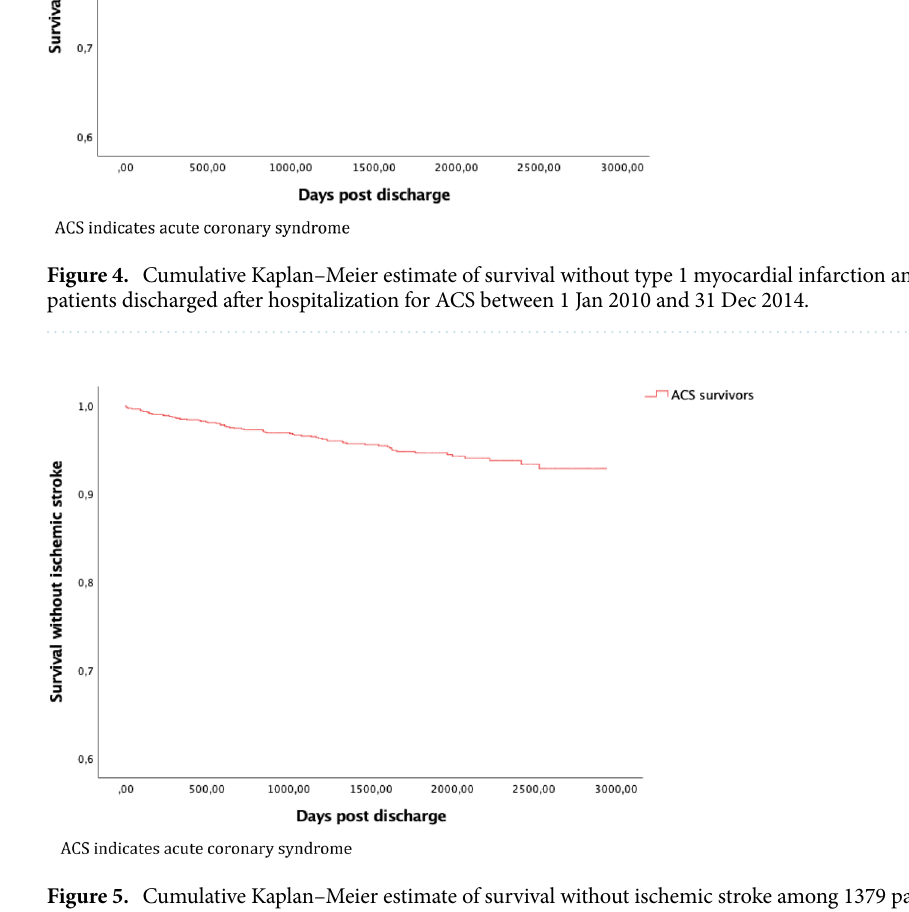
Figure 5. Cumulative Kaplan–Meier estimate of survival without ischemic stroke among 1379 patients discharged after hospitalization for ACS between 1 Jan 2010 and 31 Dec